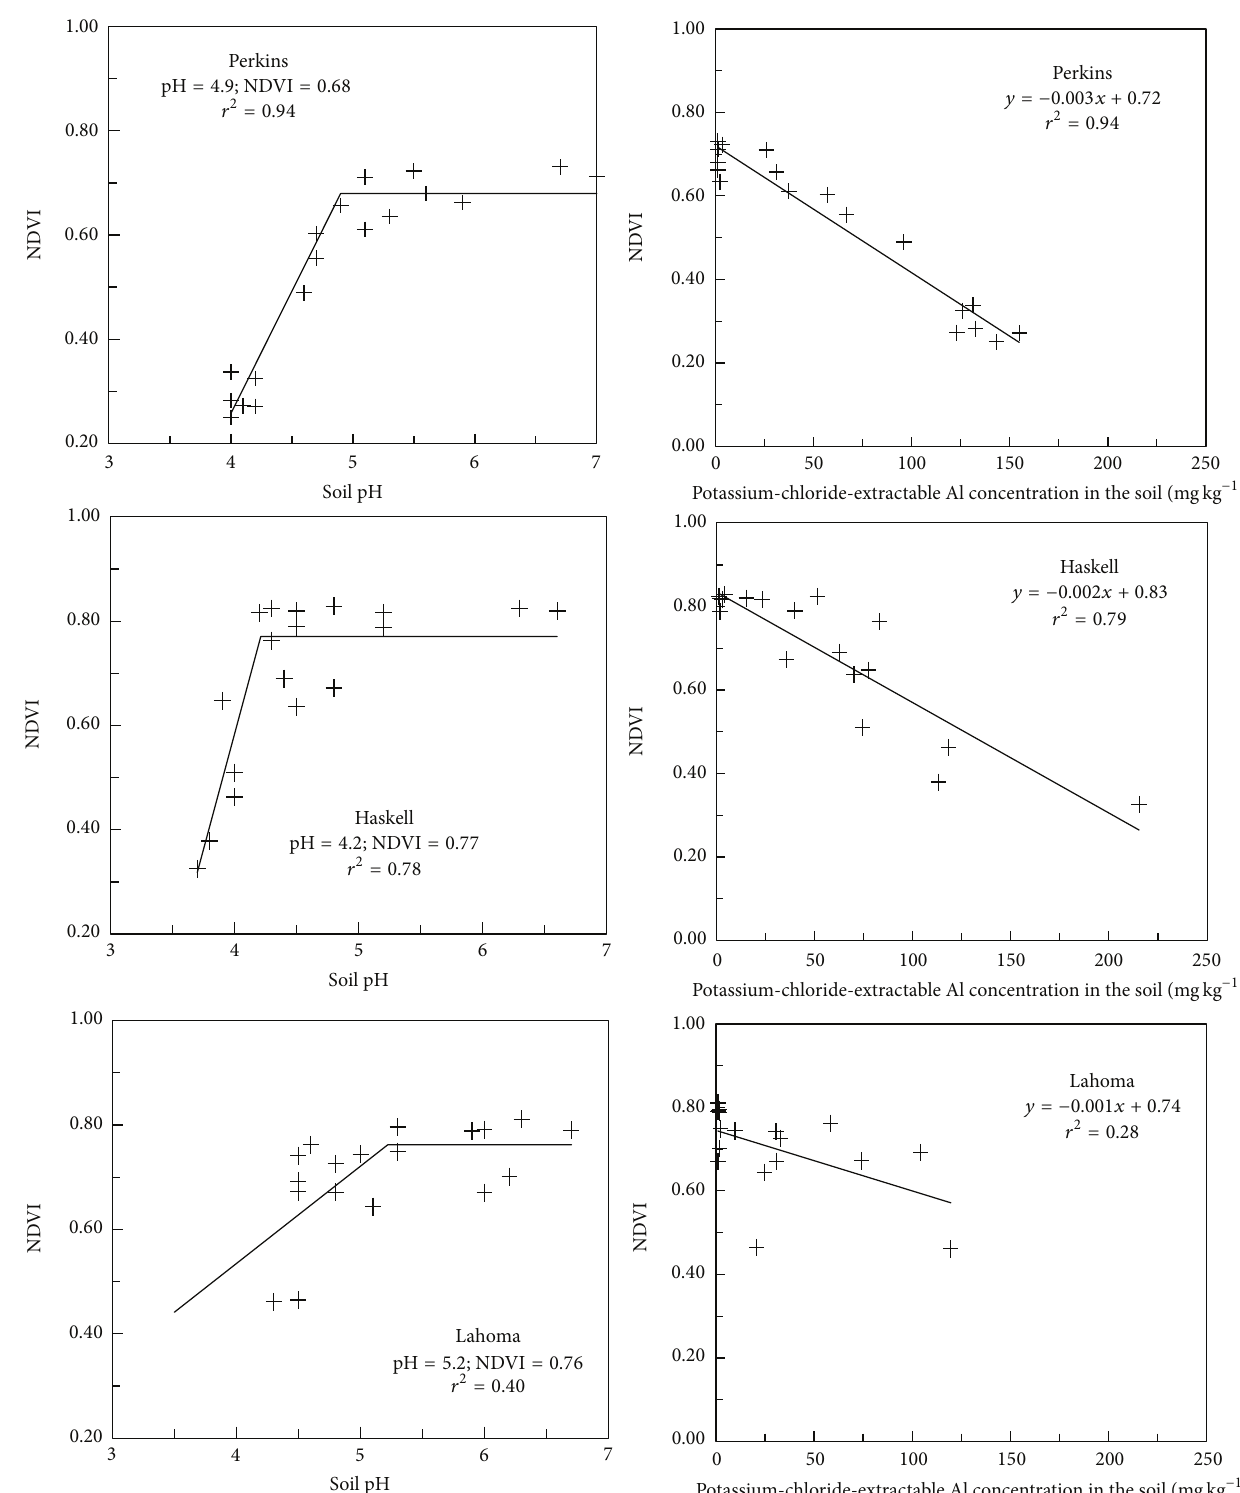
Figure 6: Normalized Difference Vegetative Index (NDVI) as a function of soil pH and potassium-chloride-extractable aluminum concentration (mg kg −1 ) in the soil at Perkins, Haskell, and Lahoma, Oklahoma, in